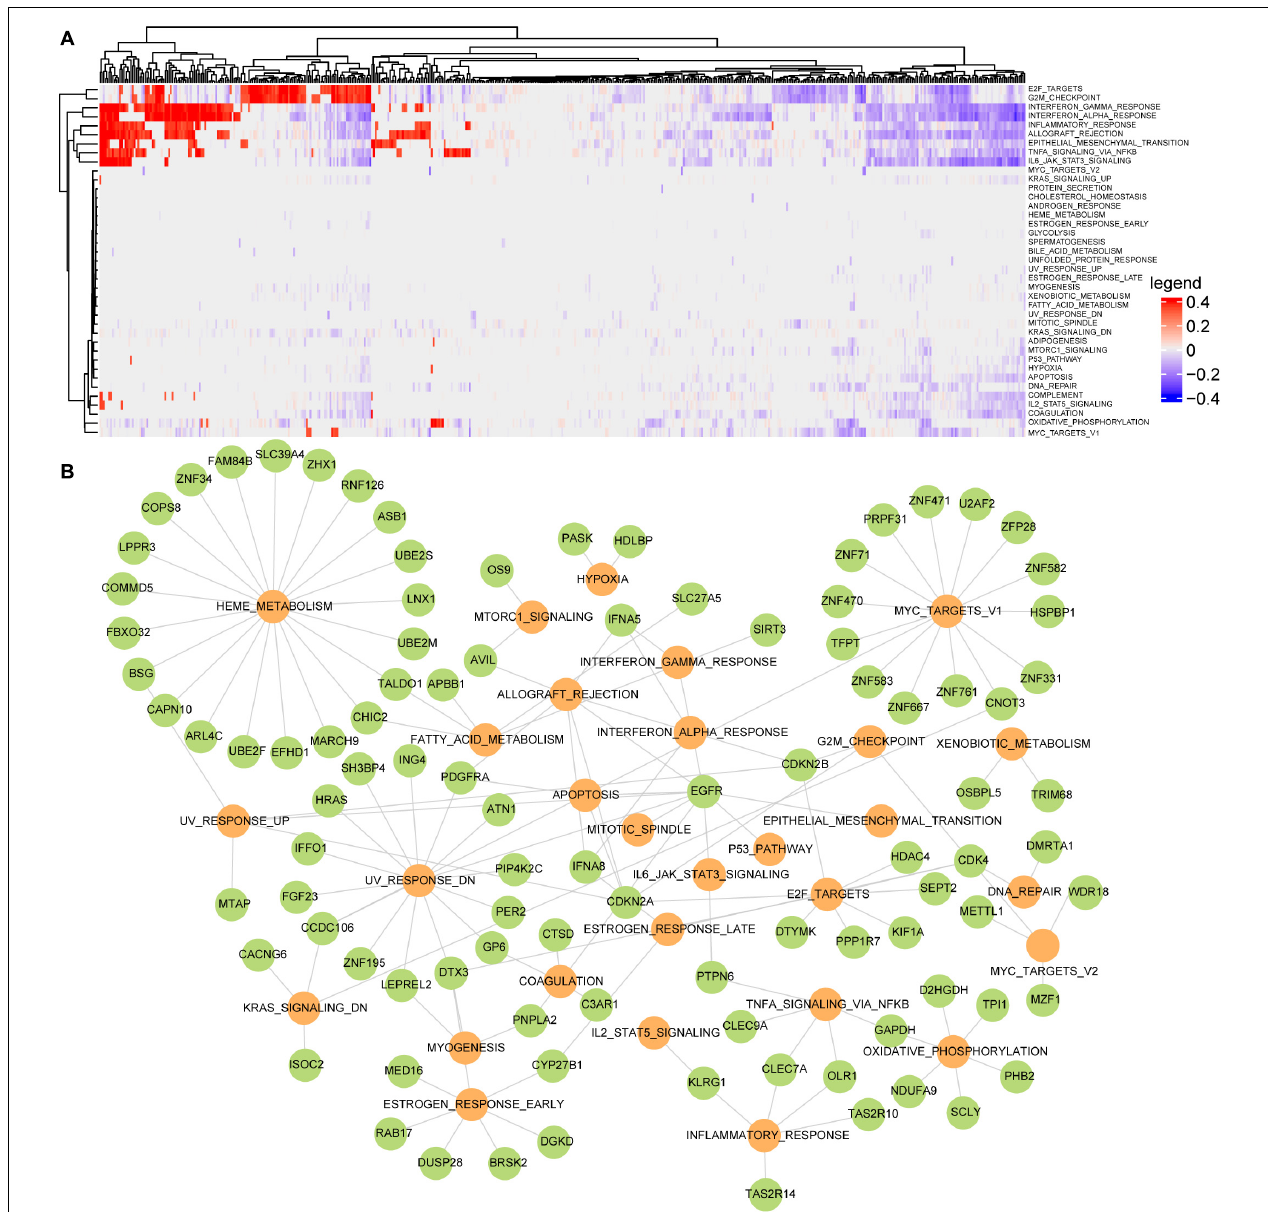
FIGURE 3 | Building the active driver gene-hallmark network using regression analysis for LGG. (A) The dysfunctional profile of cancer hallmarks for LGG; (B) the active gene-hallmark network, the green dots represent driver genes, and the yellow ones represent disordered hallmark signatures.